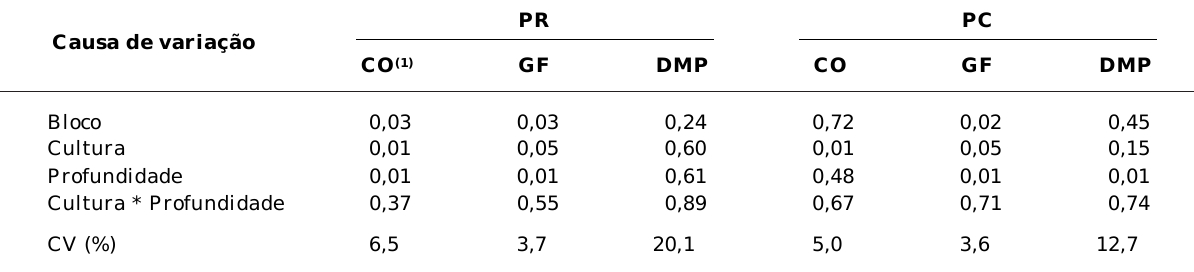
(1) CO = carbono orgânico; GF = grau de floculação e DMP = diâmetro médio ponderado.